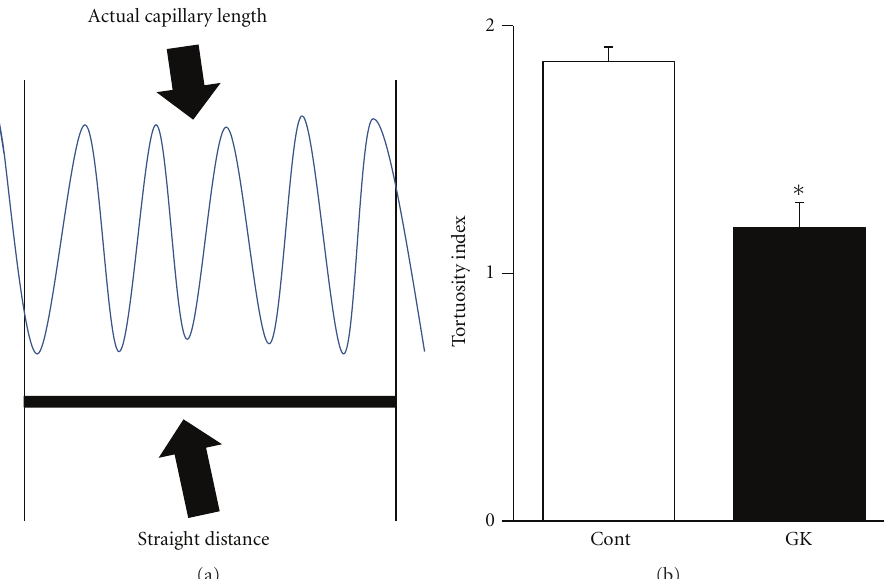
Figure 6: Tortuosity index was calculated by dividing the actual capillary length by the straight distance (a). The mean tortuosity index of the Cont rats was greater than that in the GK rats (b). ∗ P < 0 . 05.